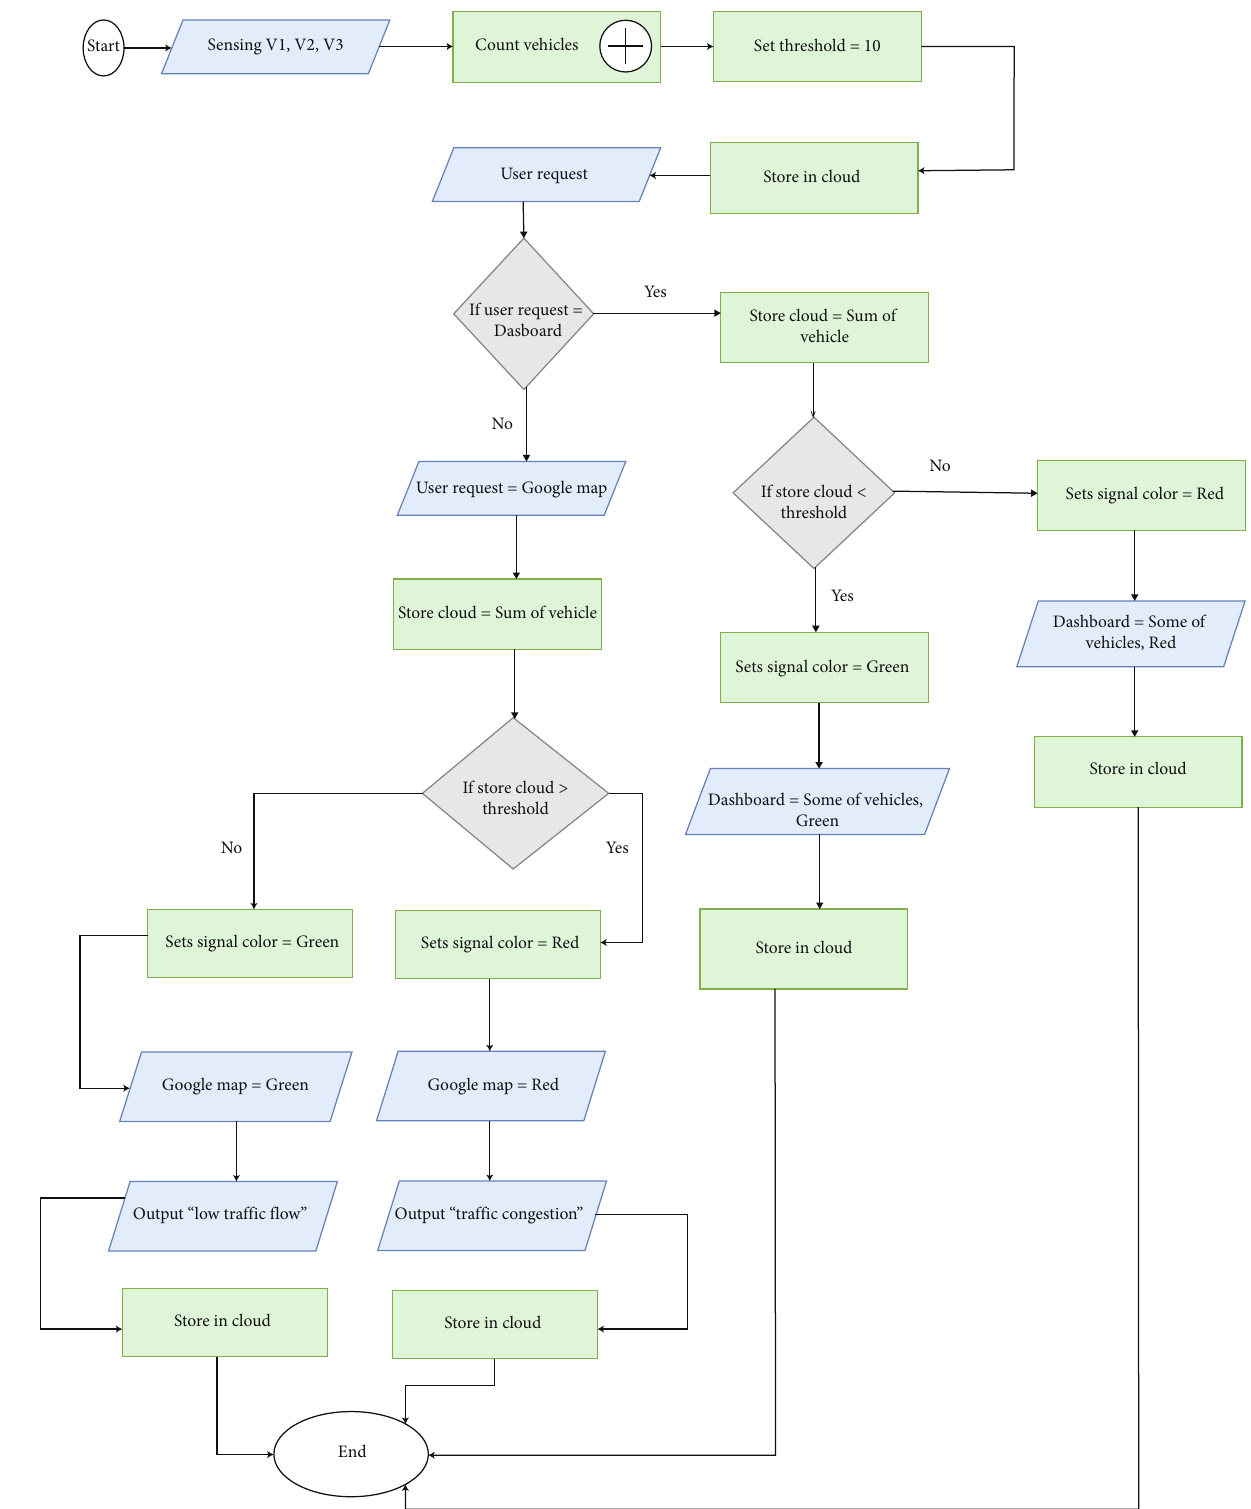
Figure 2: Real-time tra ffi c updates on signal dashboard and Google